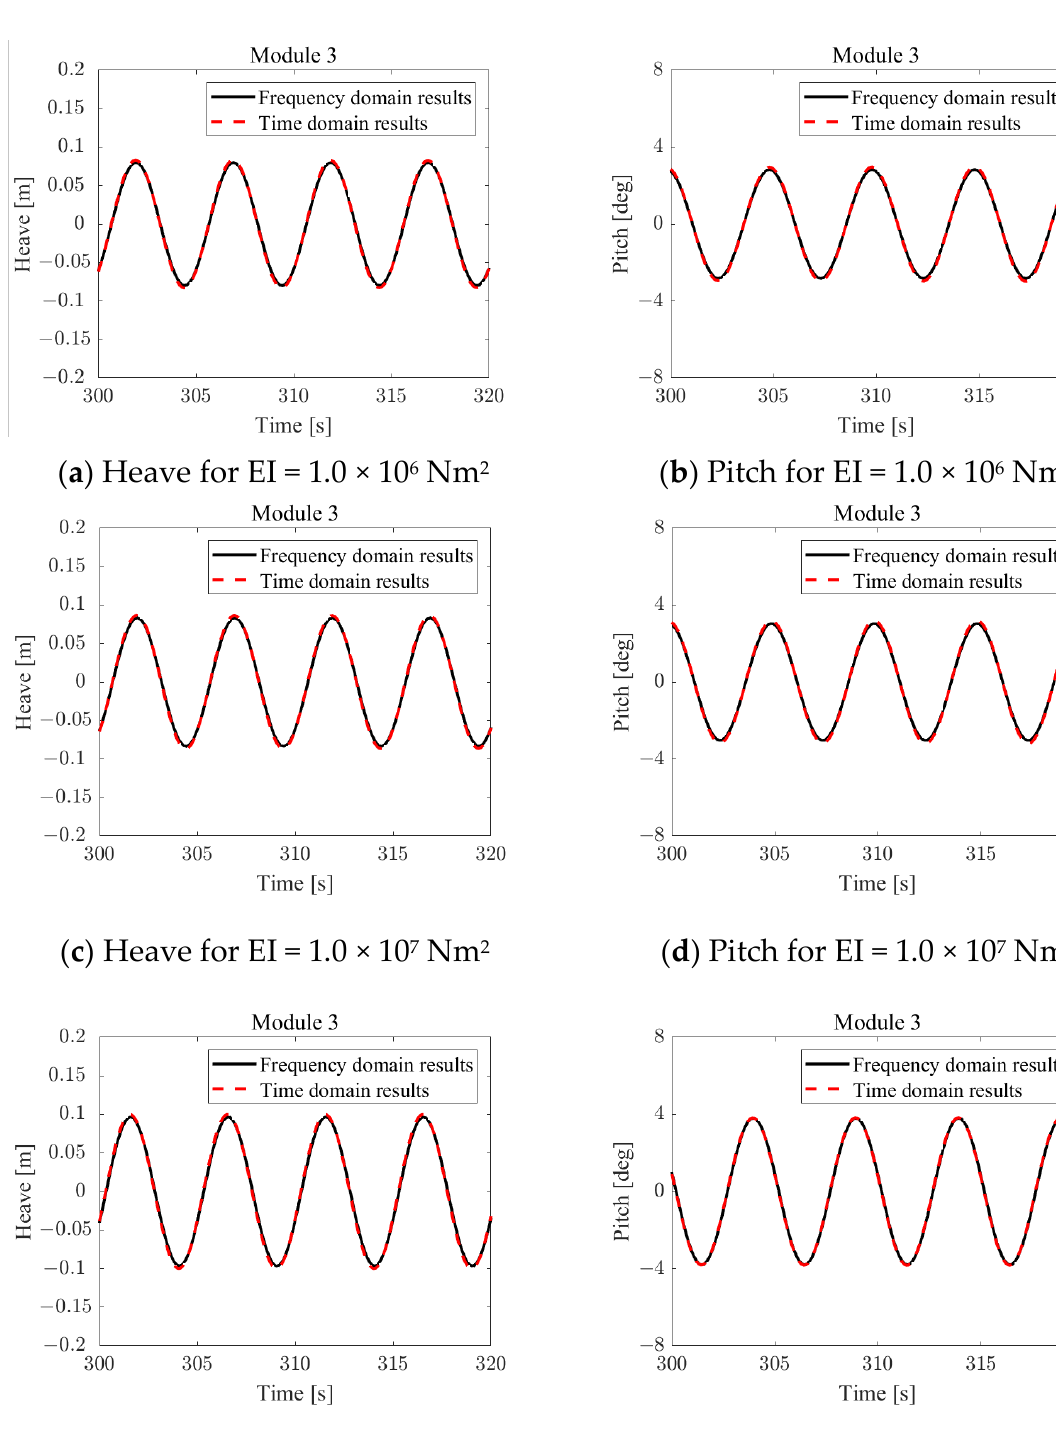
Figure 12. Comparisons of heave and pitch motions of Module 3 between the RAO-based response and CPHSTDM-based response under the regular wave of ω = 1.26 rad/s and wave amplitude of 2 m in the head sea for different connector stiffness.